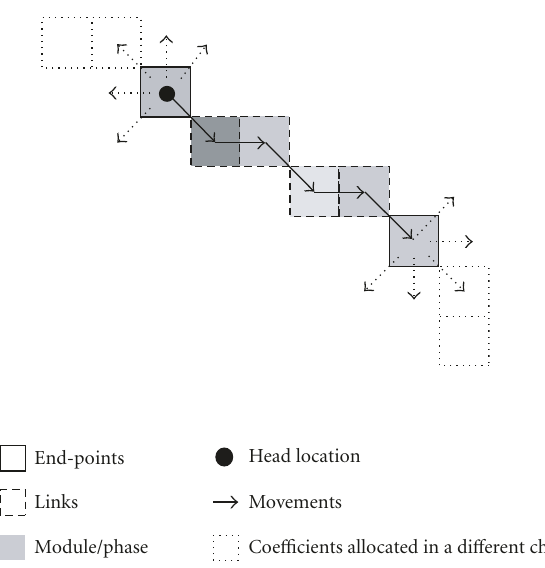
Figure 6: Scheme proposed for contour